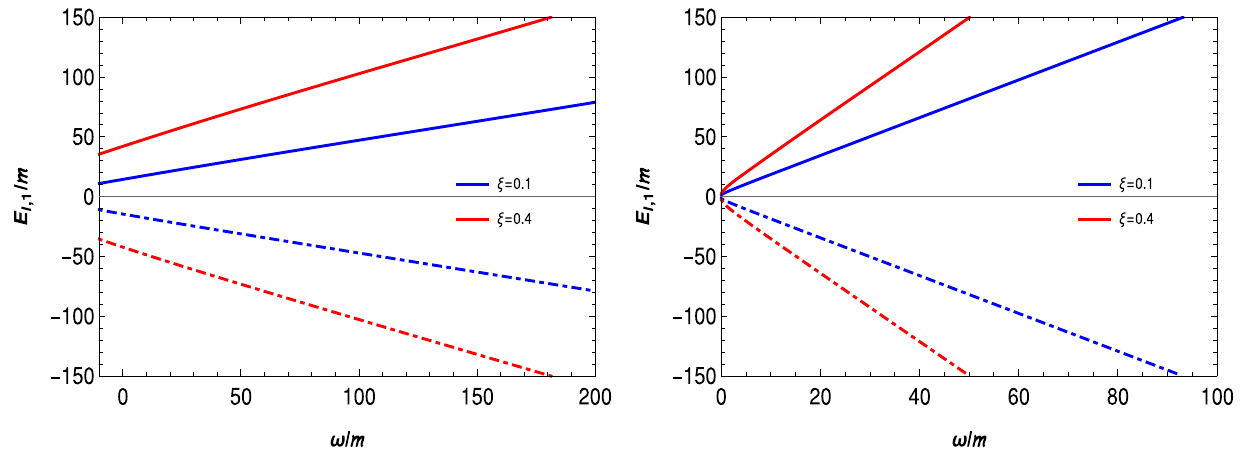
Fig. 3 In both graphs contained in the figures on the right and left, we | as a function of ω/ m . In the figure on the left, we have the have | E l , 1 m setting of the parameter α = 0 . 1 and two values of the parameter ξ . The continuous curves represent the positive sign of the spectrum Eq. (35)